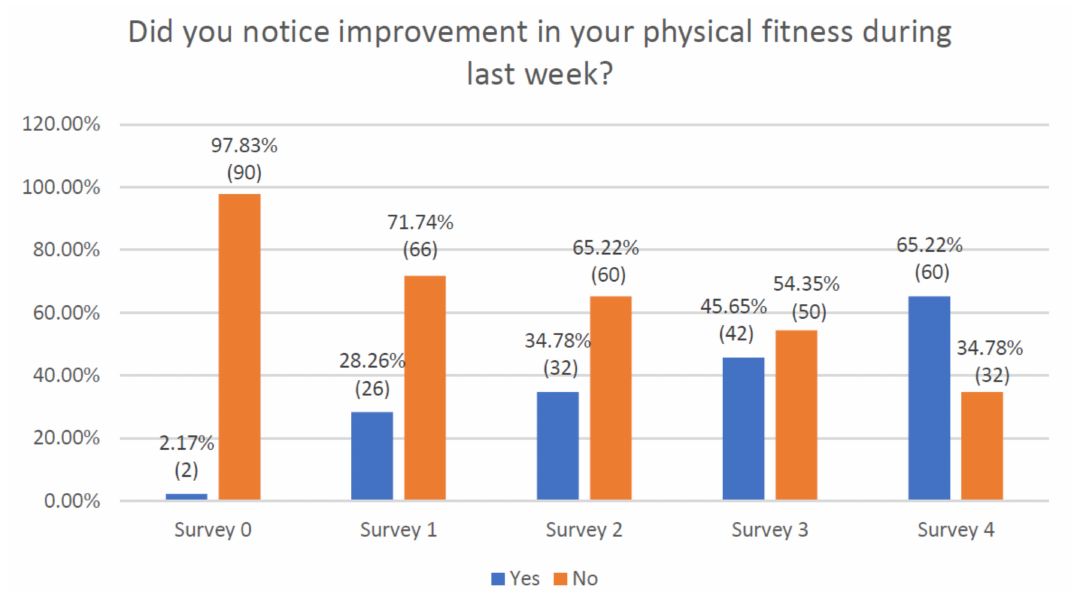
Figure 7. Declaration of respondents regarding improvement in their fitness over the last week.